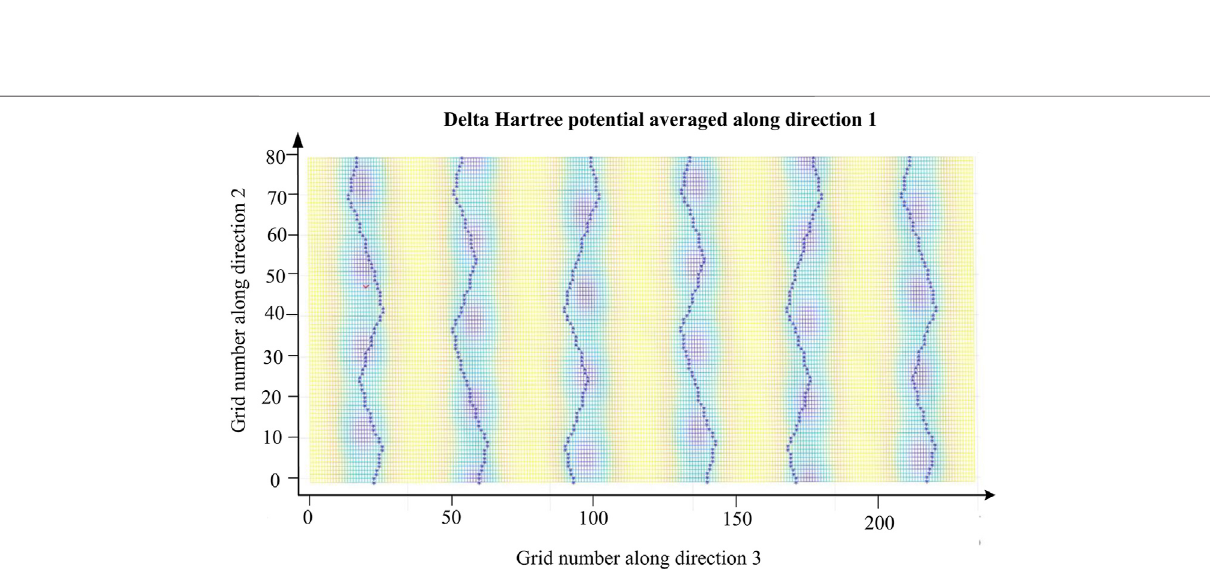
Frontiers in Physics |